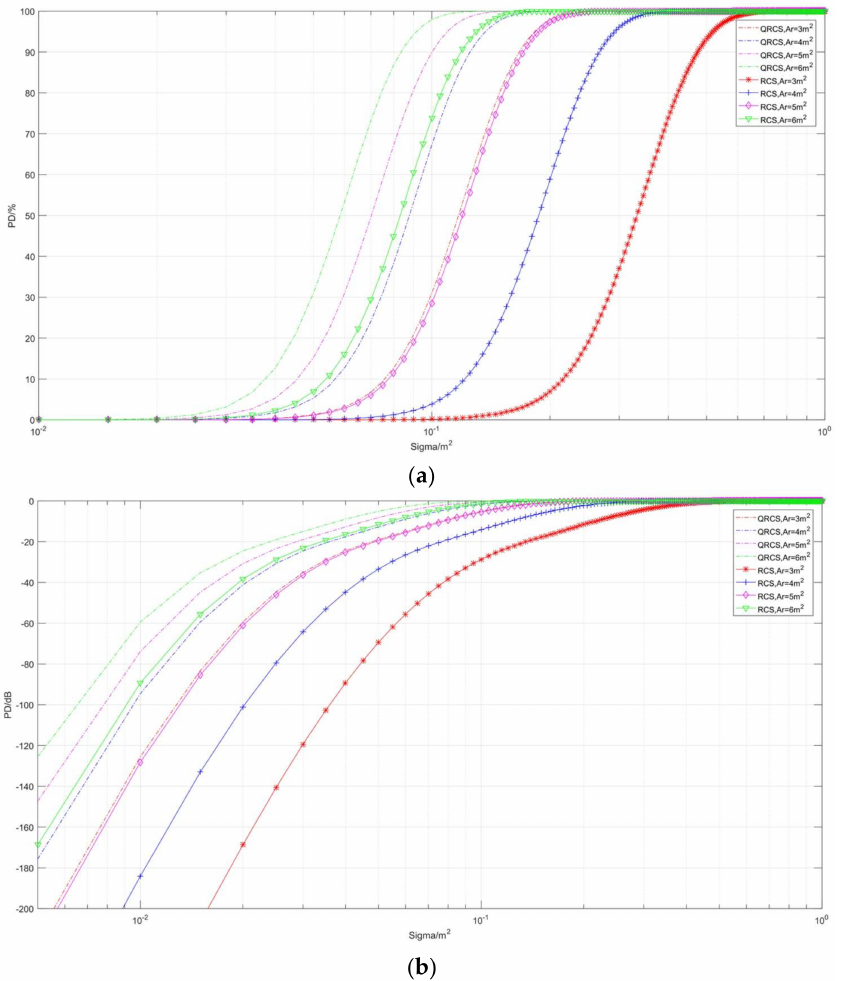
Figure 12. Correlation diagram of detection probability changing with RCS and QRCS (Taking different A r ). ( a ) P D /%, ( b ) P D